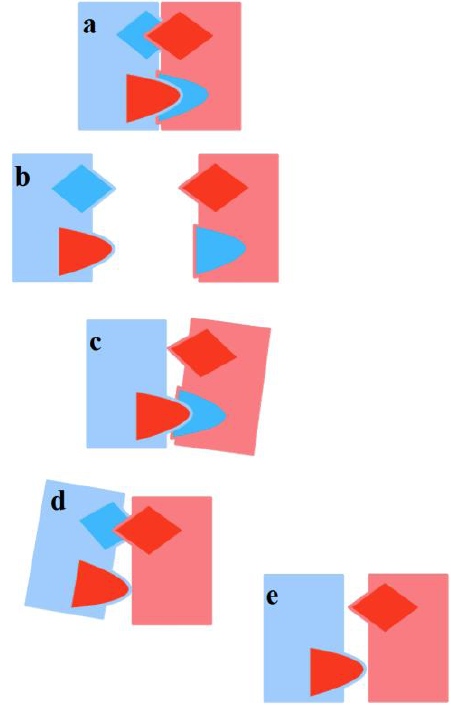
Figure 4. Possible cases. ( a ): Formation of a stable couple with Double Tie-Up (D-TU); ( b ): Lack of TU and non-existence of the couple; ( c ): F-TU only; ( d ): M-TU only; ( e ): Couple without TUs. RAs not shown are not activated.